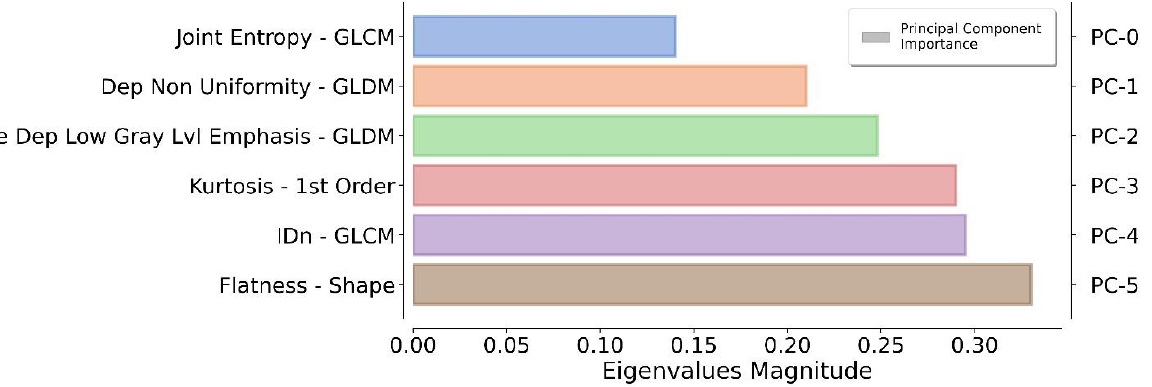
Figure 3. Ranking of the top informative features identified by the proposed pipeline. For each principal component (on the right ), the original feature (on the left ) that contributes the most to the related principal component is reported.